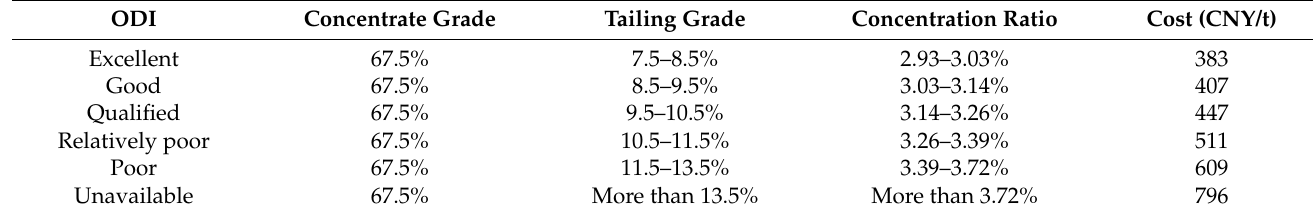
Table 8. The nature and production cost of beneficiation products.